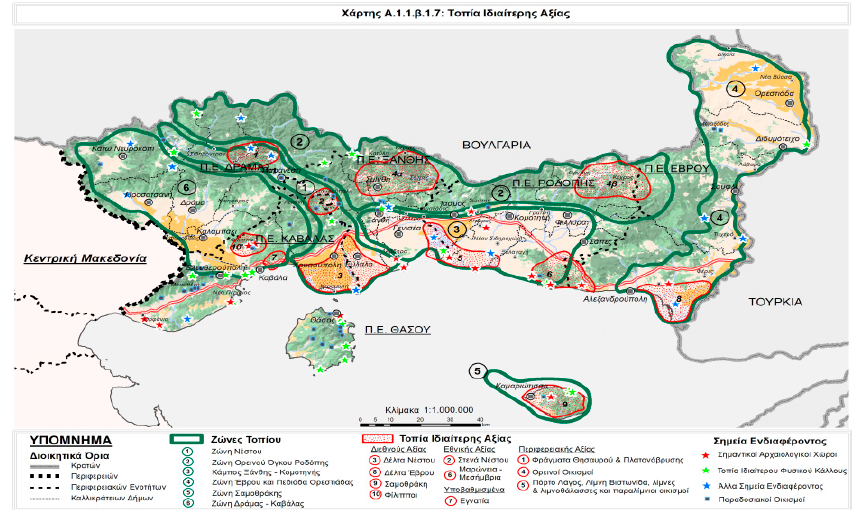
Figure 2. Landscape map of the East Macedonian and Thrace Region, source: Ministry of Environment and Energy, Revision and evaluation studies of Crete and East Macedonia -Thrace Regional Spatial Plans accordingly, 2016.